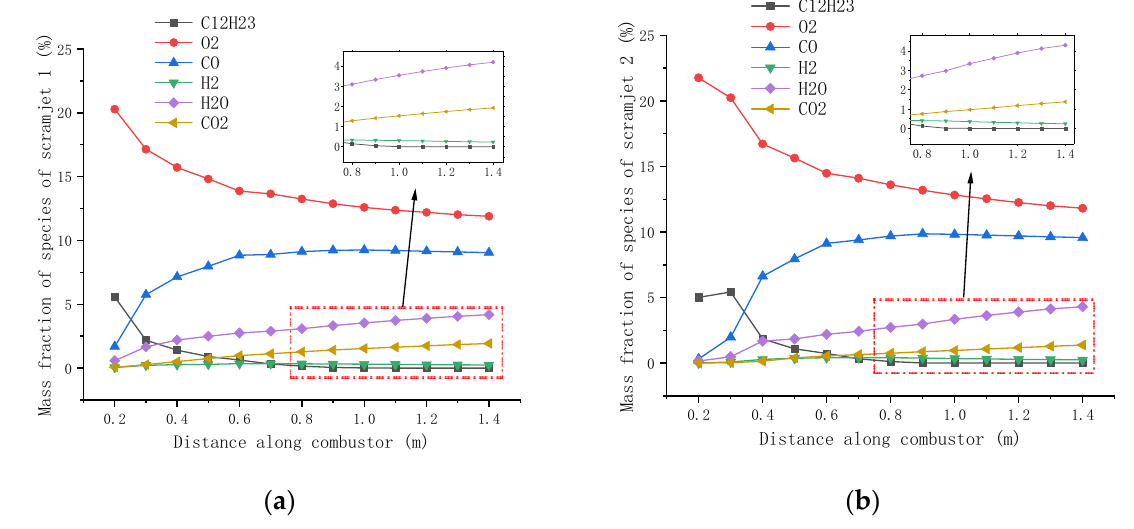
Figure 9. Species mass fraction for ( a ) scramjet 1 and ( b ) scramjet 2.